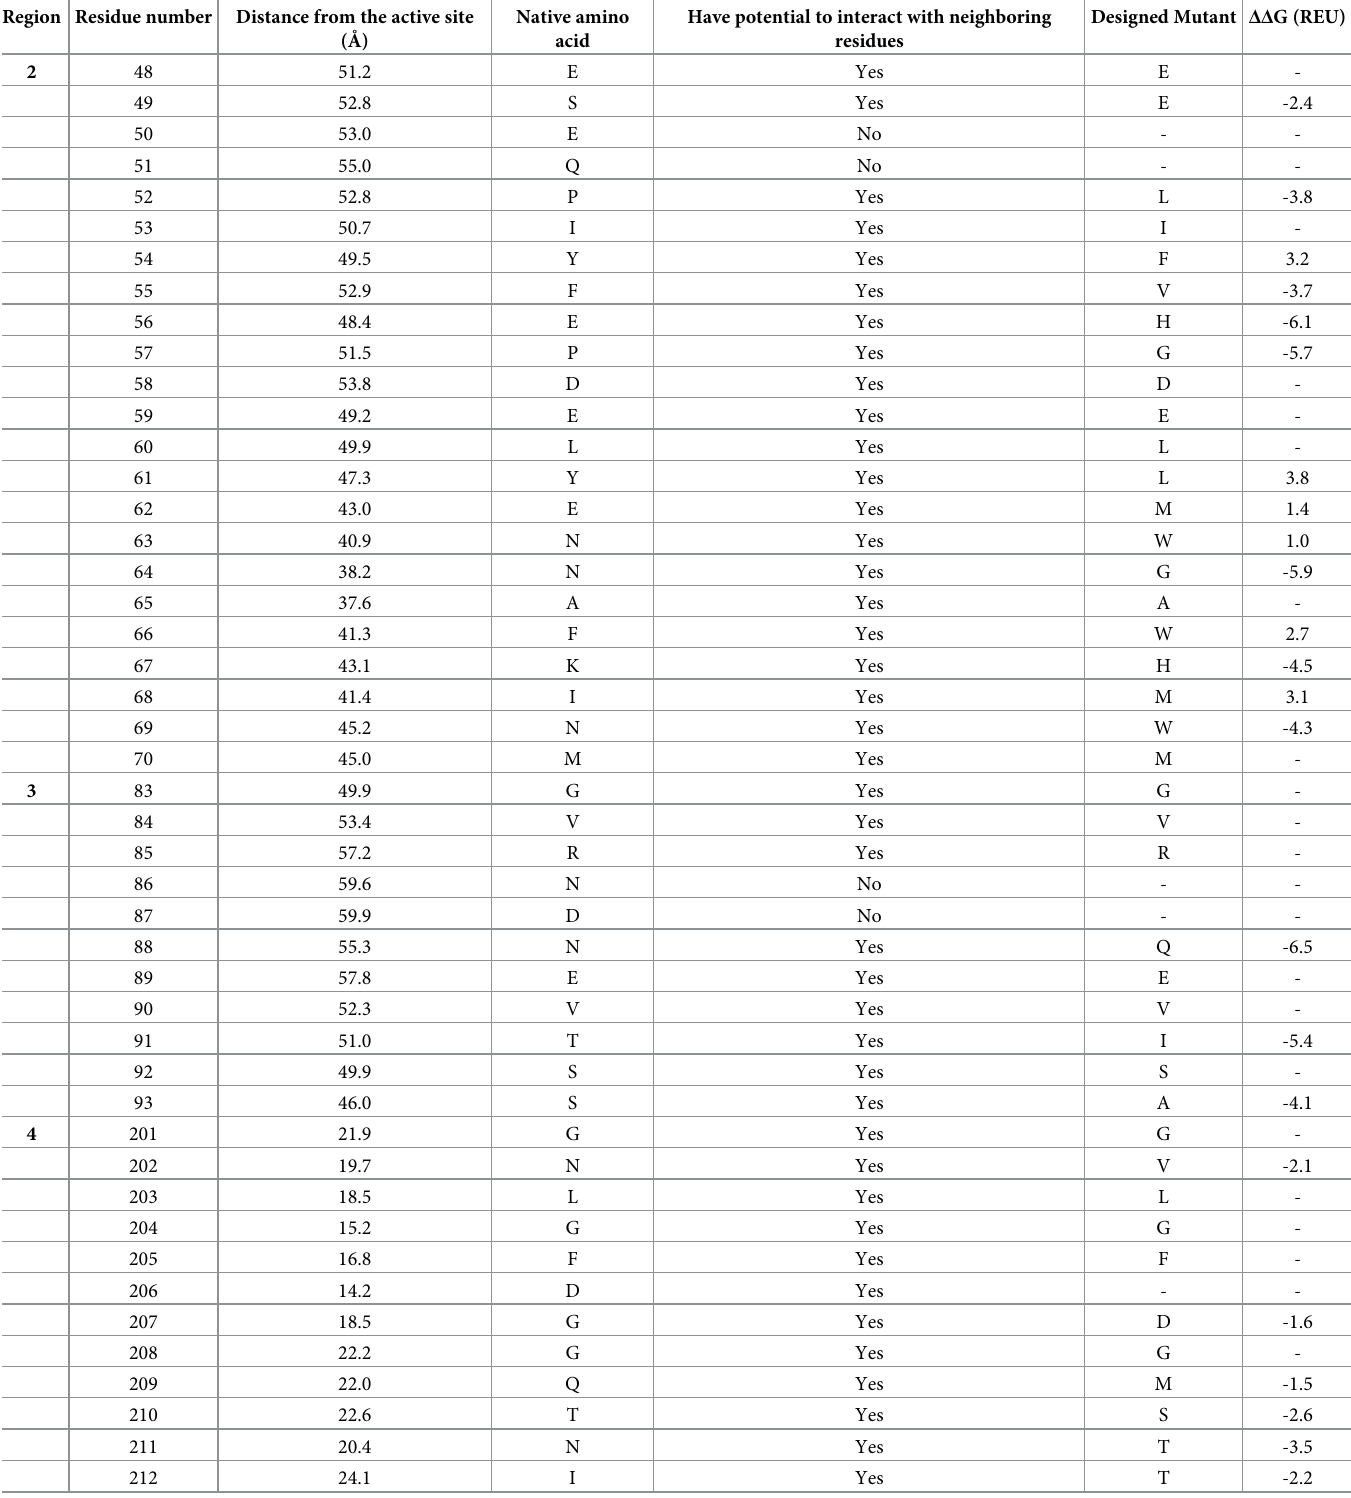
Table 2. The ΔΔ G values of the designed mutants. Region Residue number Distance from the active site